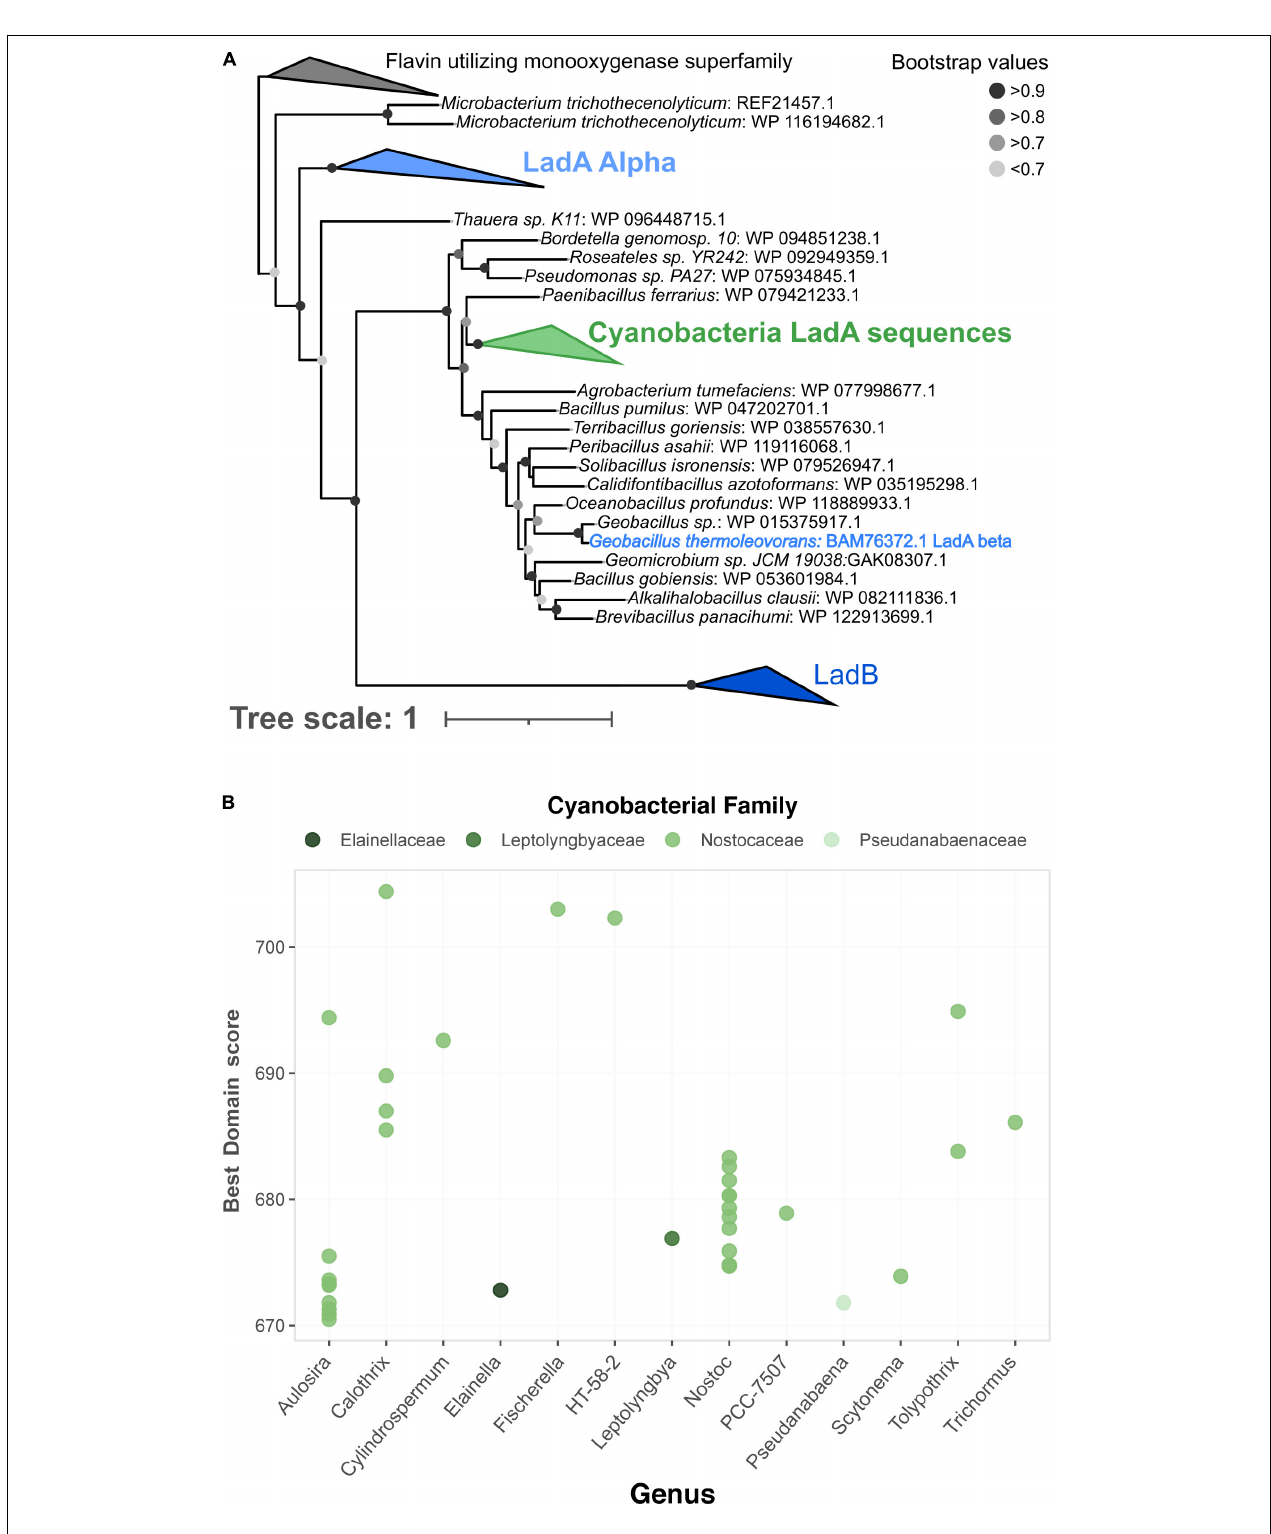
FIGURE 5 | Detection of long-chain alkane monooxygenase (Lad) family of genes in Cyanobacteria. (A) Phylogenetic tree of Lad sequences including a cluster of 102 sequences detected in Cyanobacteria genomes by CANT-HYD (green). (B) Distribution of scores for LadA beta HMM hits in Cyanobacteria genomes. Original tree file for is available as Supplementary Data Sheet 1